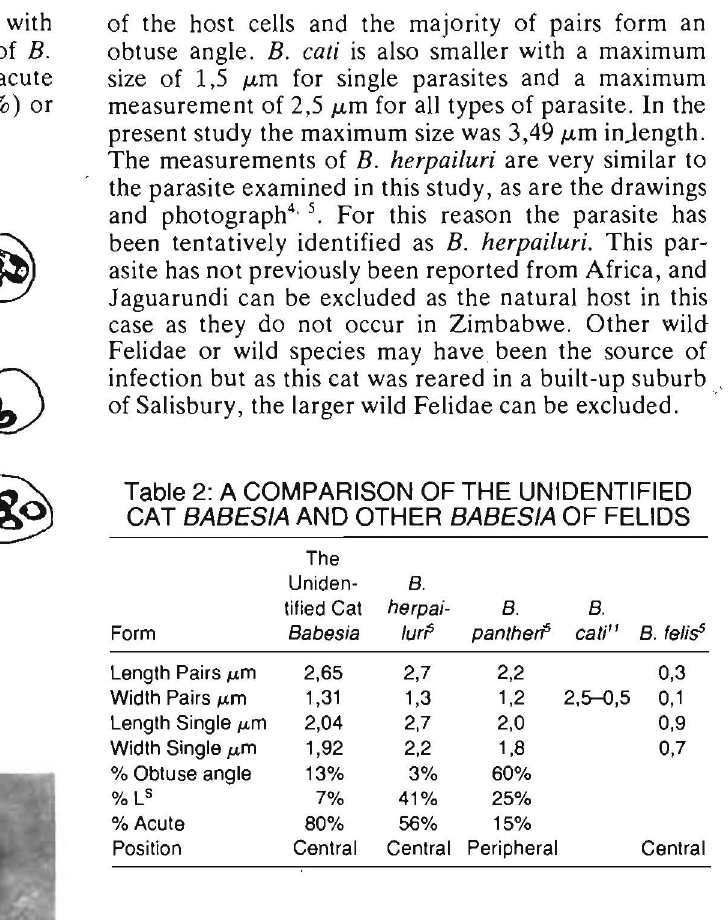
Table 2: A COMPARISON OF THE UNIDENTIFIED CAT BABESIA AND OTHER BABESIA OF FEUDS The Uniden· B. tified Cat herpai- B. B. Form Babesia